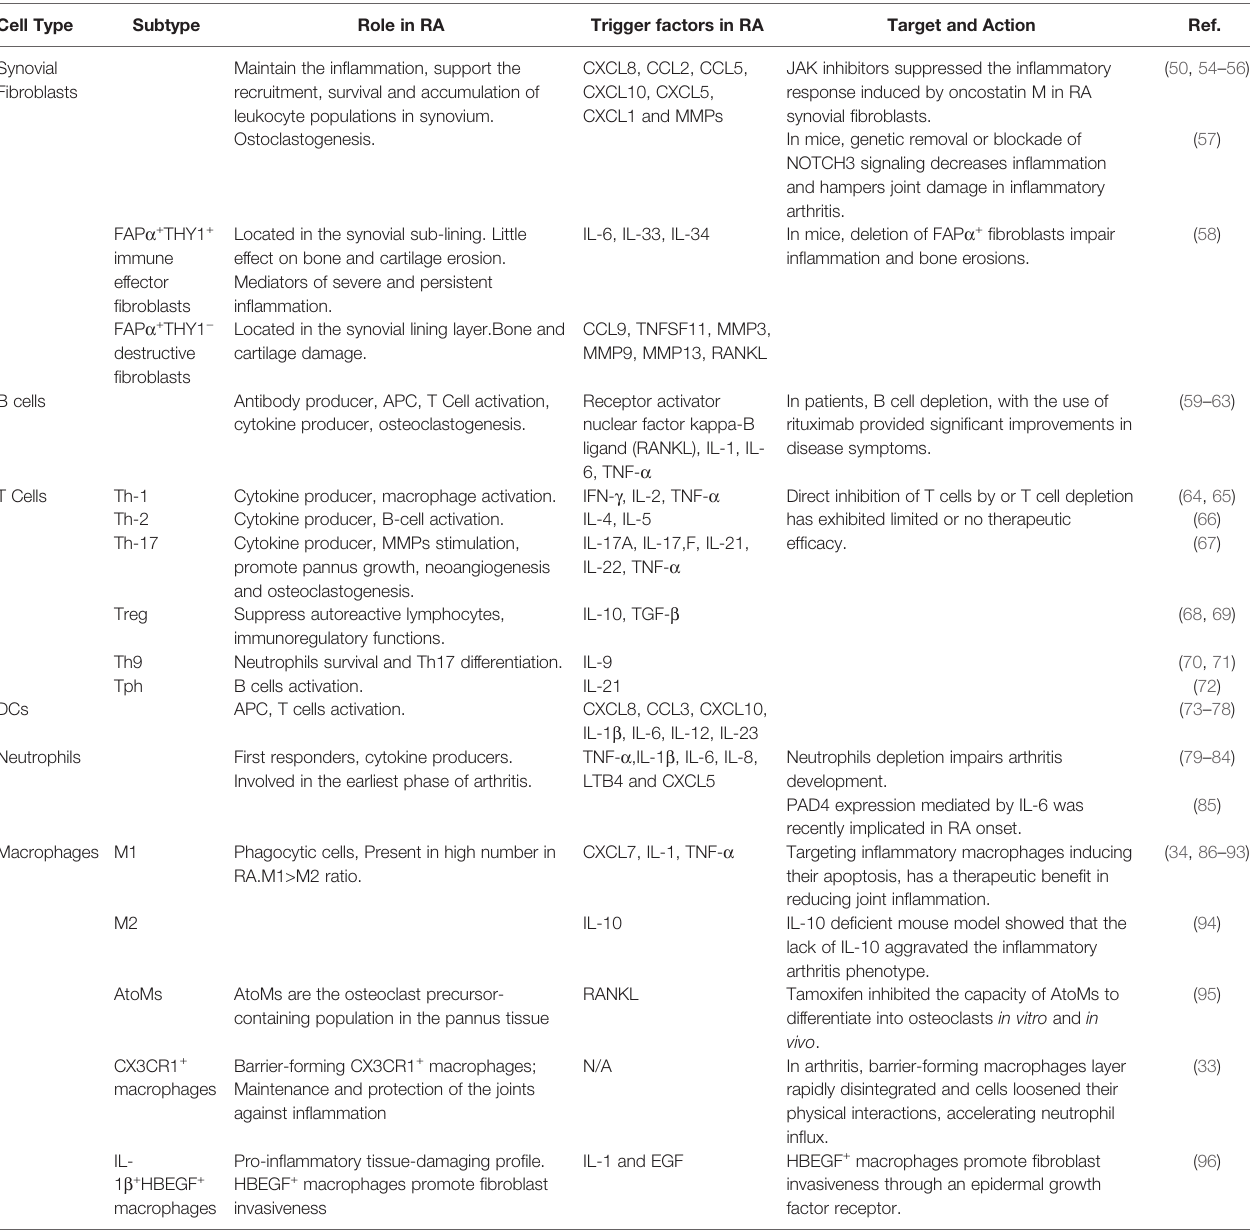
TABLE 1 | Contribution of different cell types to Rheumatoid